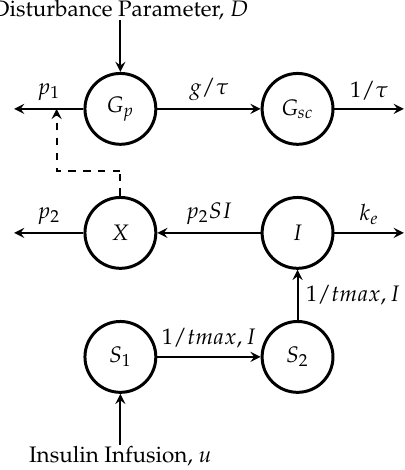
Figure 1. Compartmental model of glucose-insulin system. G p and G sc represent glucose concentrations in the accessible (plasma) and non-accessible (subcutaneous) compartments, I represents plasma insulin, and X represents a remote insulin compartment that accelerates glucose disappearance